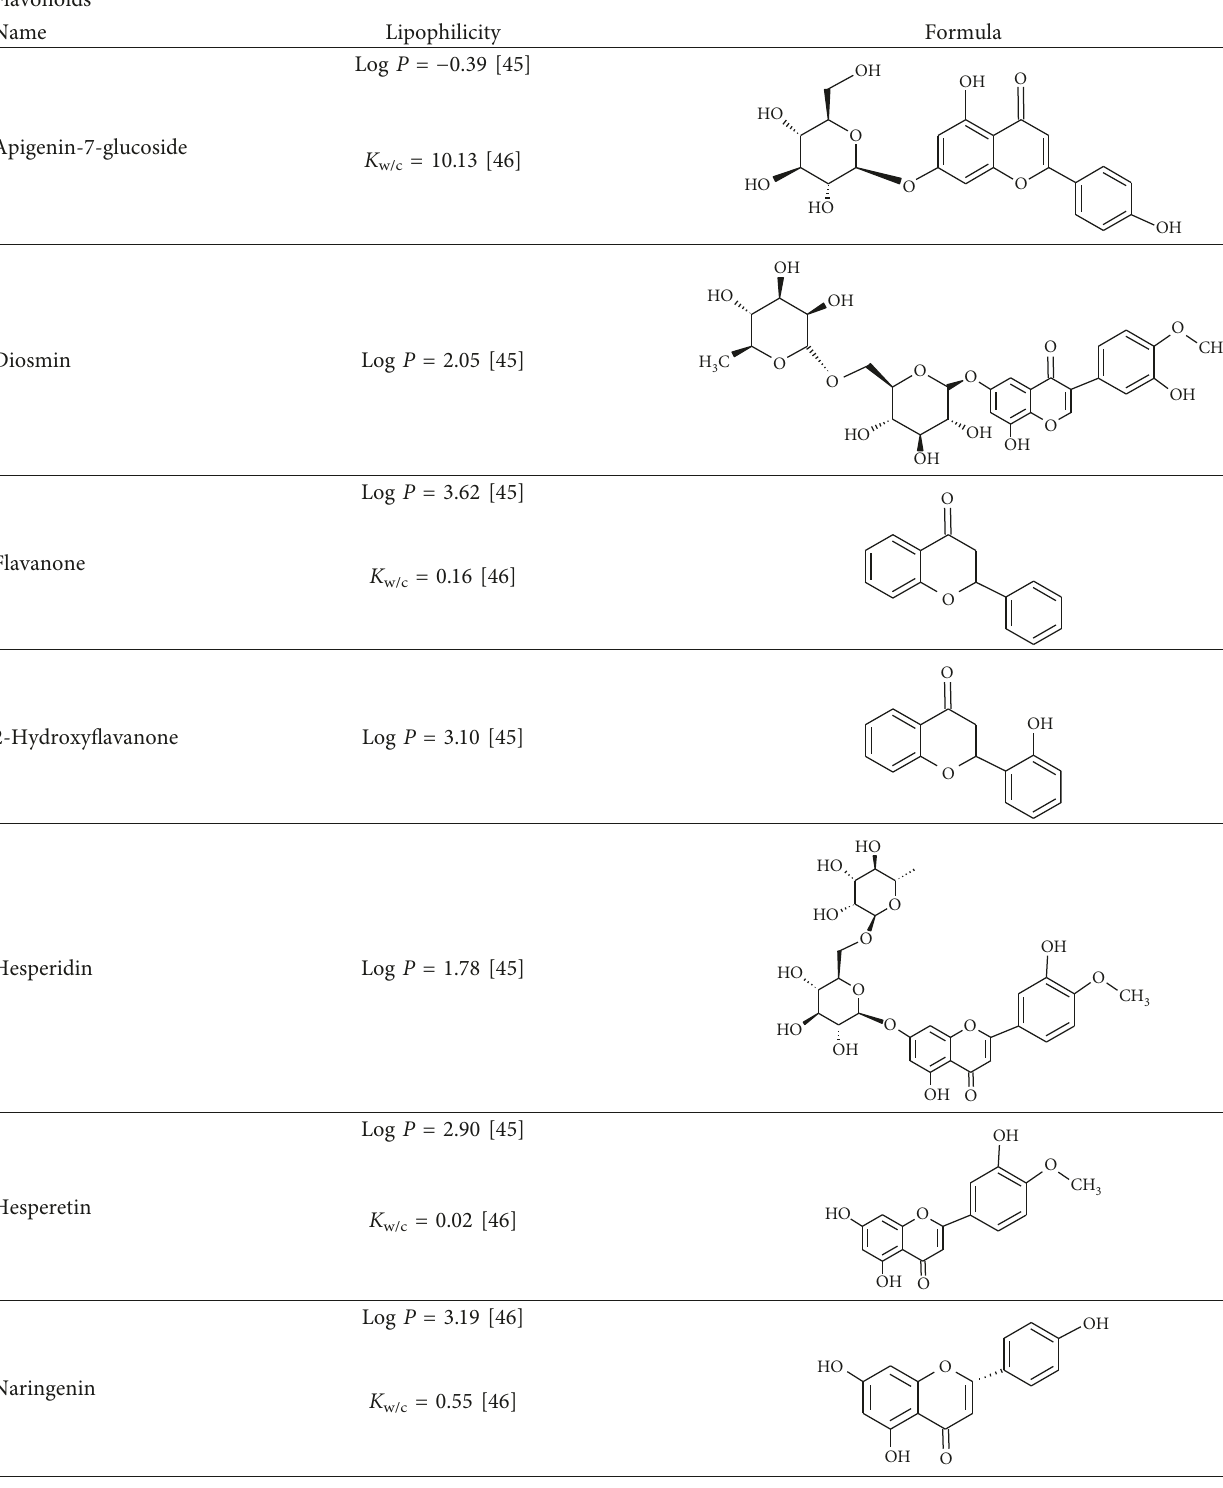
Table 1: Structural formulas and physicochemical properties of investigated